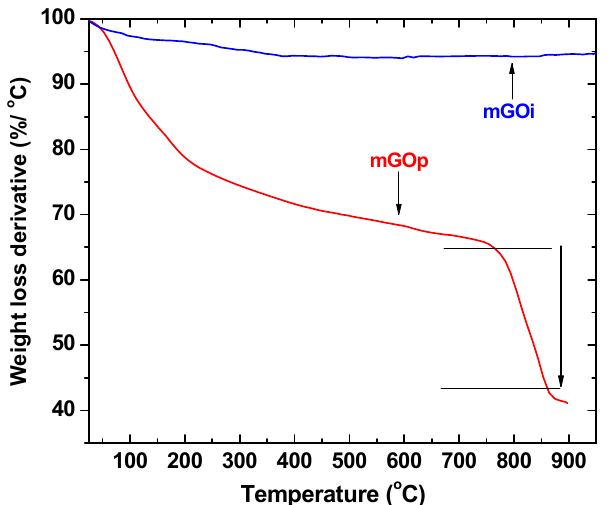
Figure 4. Differential thermogravimetry (DTG) curves in